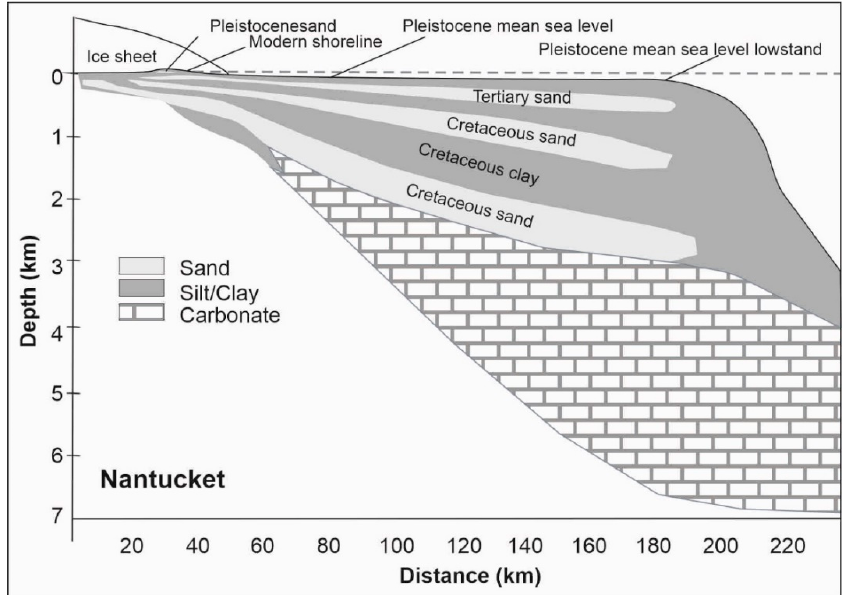
Figure 7. Geo-hydrostratigraphic cross section for Nantucket, Massachusetts (modified from Reference [95]). The position and thickness of the Laurentide Ice Sheet at the Last Glacial Maximum at ca. 21 ka are estimated from Reference [114]. The cross section is constructed by using borehole lithologic and hydrogeologic data from References